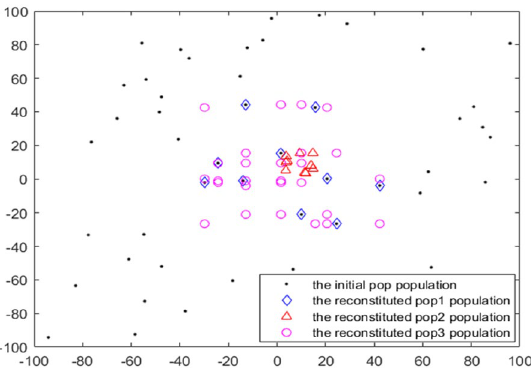
Figure 6. Comparison of individual distribution before and after population